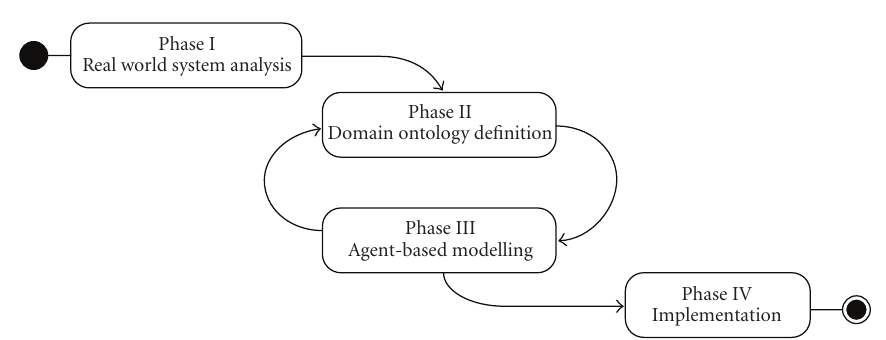
Figure 7: The phases of the